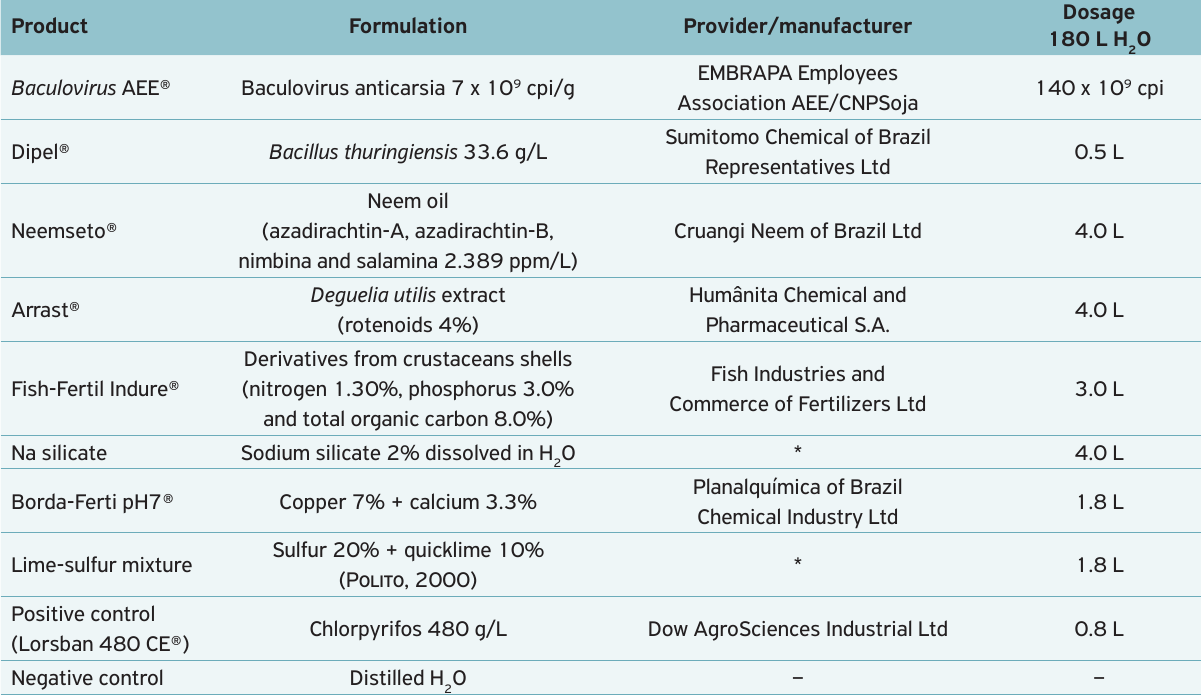
Table 1. Treatments tested against pupae and adults of the egg parasitoid Trichogramma pretiosum